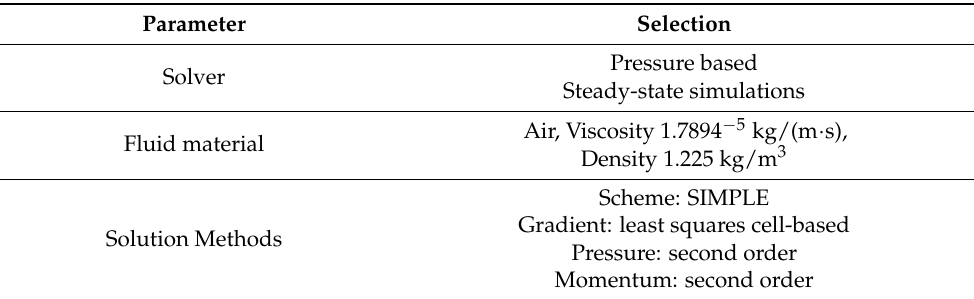
Table 2. Solver setup and fluid properties used in the analysis.